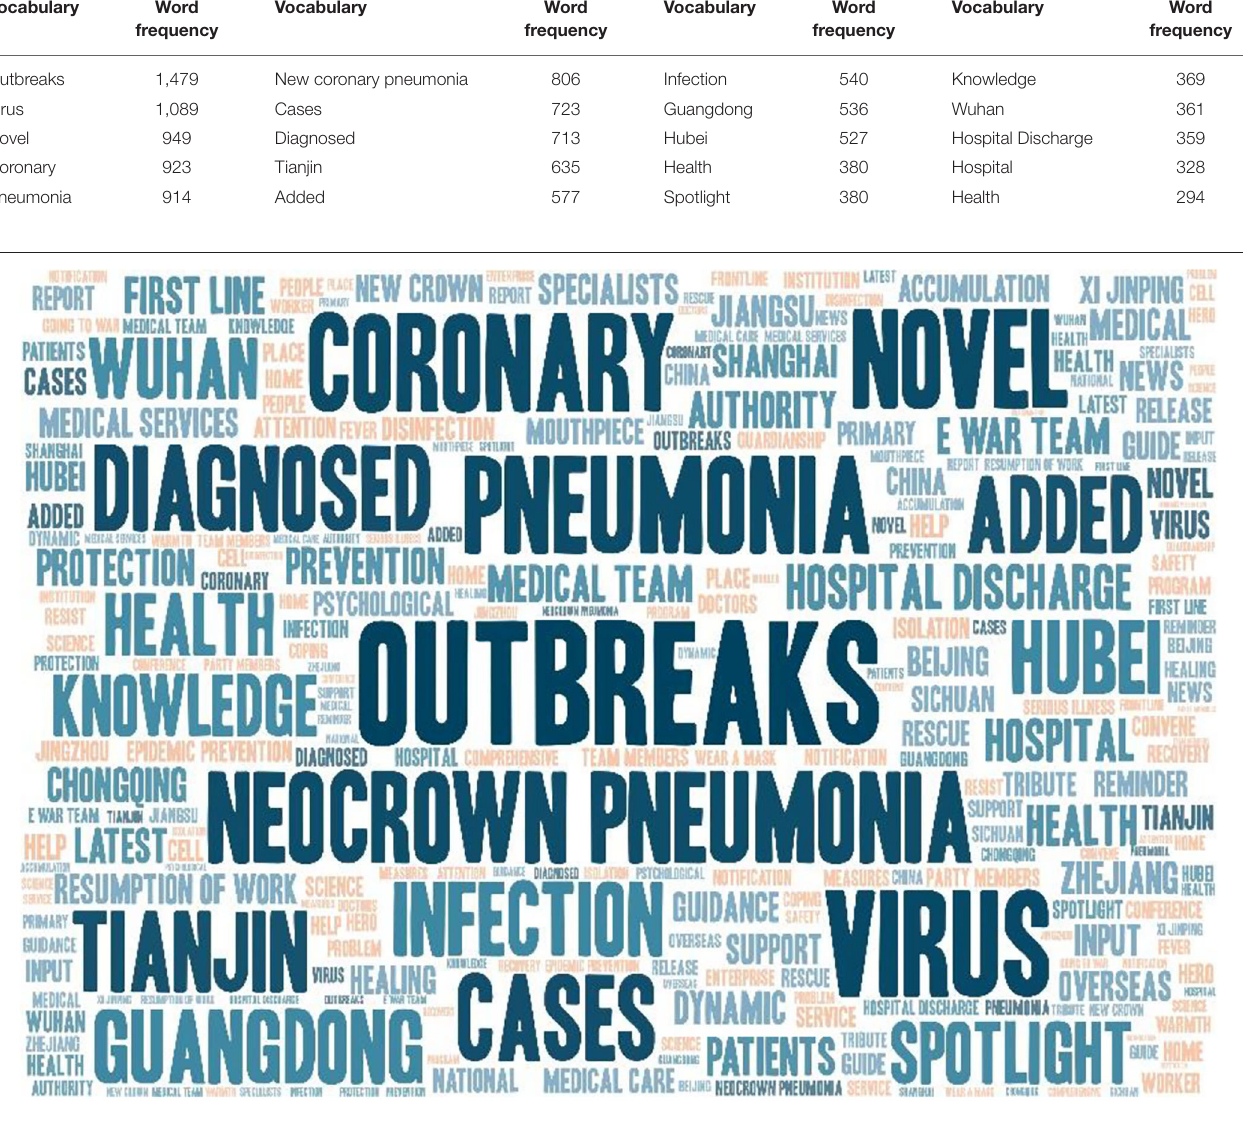
FIGURE 7 | Tweets title high-frequency words word cloud